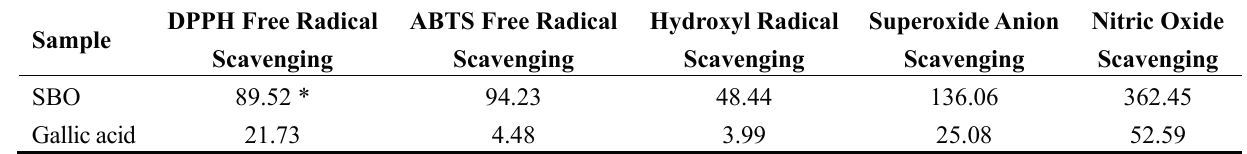
Table 3. Free radical scavenging potential of Japanese red pine sawdust bio-oil (SBO). DPPH Free Radical ABTS Free Radical Hydroxyl Radical Superoxide Anion Nitric Oxide Sample Scavenging Scavenging Scavenging Scavenging Scavenging SBO 89.52 *